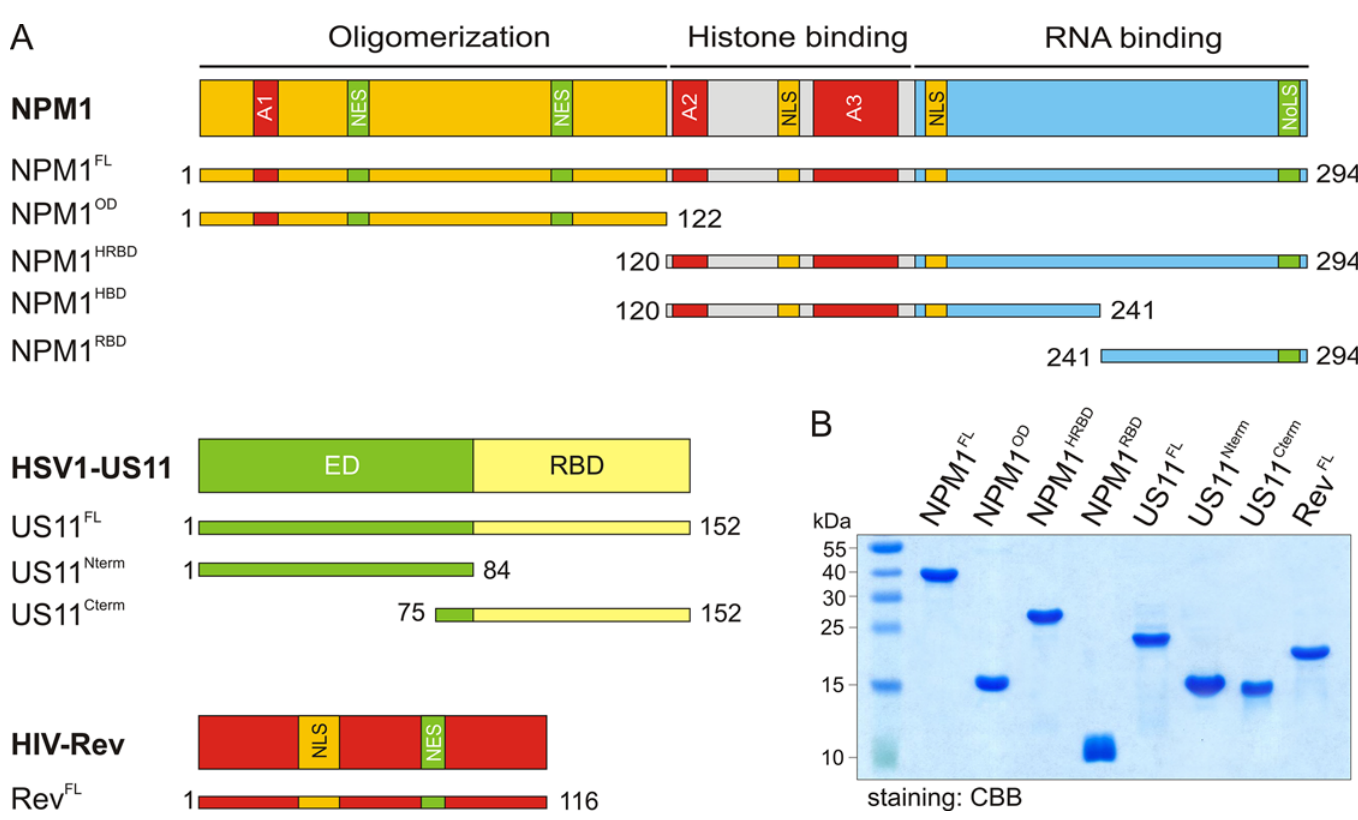
Fig 1. Schematic representation of domain organization, various constructs and proteins of NPM1, HSV-1 US11, and HIV-1 Rev. (A) Domains and various constructs of NPM1, US11 and Rev. The numbers indicate the N- and C-terminal amino acids of the respective constructs used in this study. A1-A3, acidic regions 1 – 3; Cterm, C-terminal; ED, effector domain; FL, full-length; HRBD, histone and RNA-binding domains; HBD, histone binding domain; NES, nuclear export signal; NLS, nuclear localization signal; NoLS, nucleolar localization signal; Nterm, N-terminal; OD, oligomerization domain; RBD, RNA- binding domain. (B) Coomassie brilliant blue (CBB) stained SDS-PAGE of purified proteins used in this study.